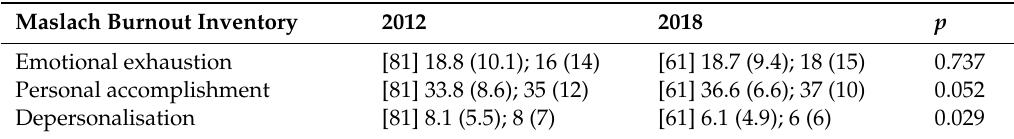
Table 4. Comparison of Maslach Burnout Inventory scores in 2012 and